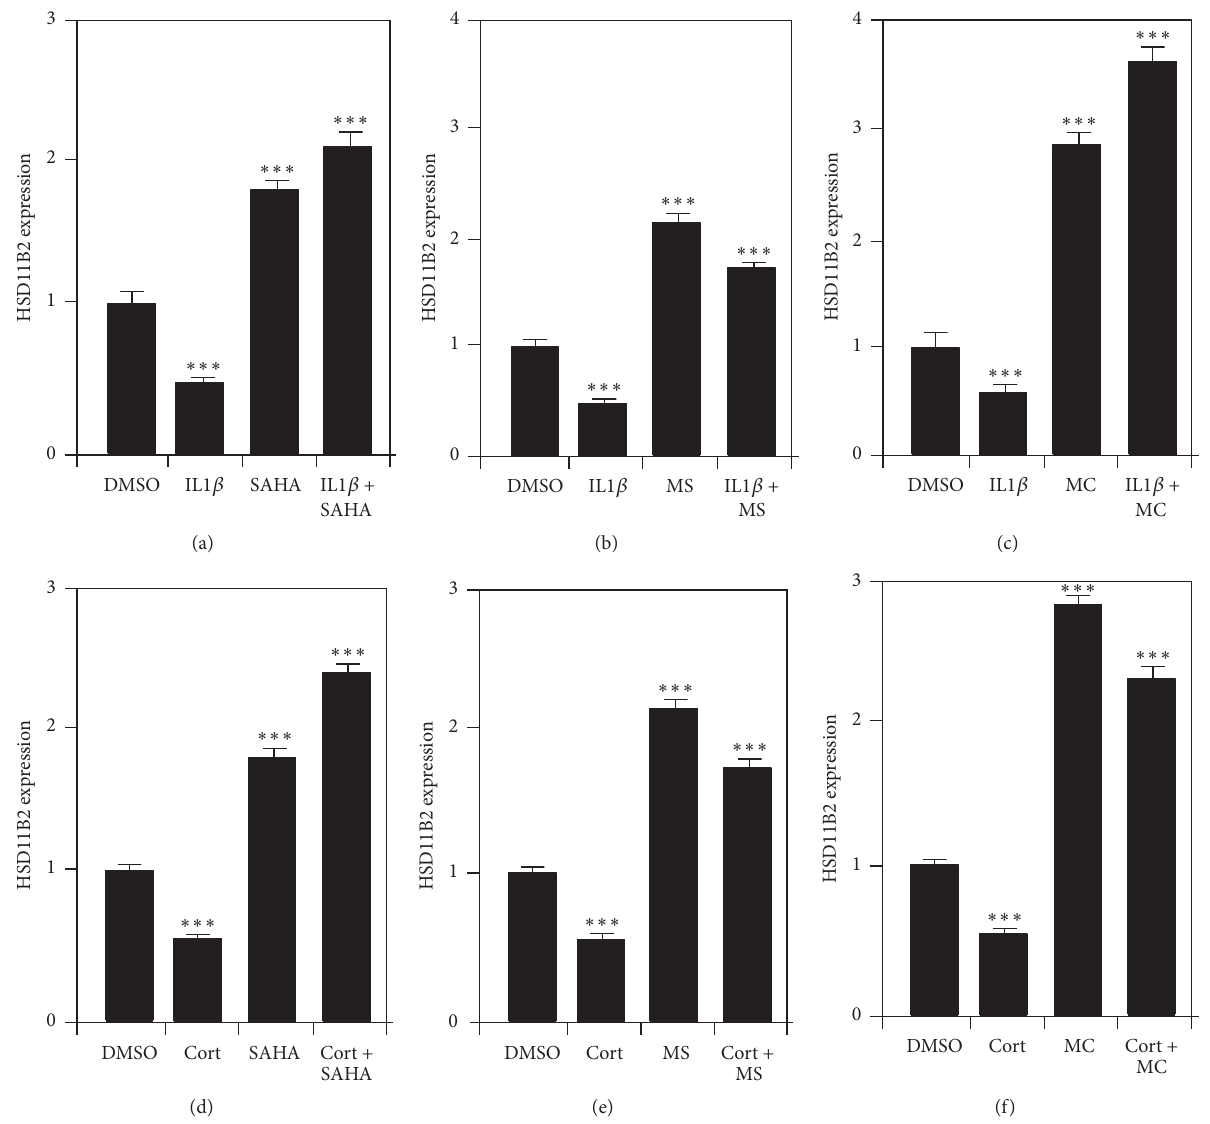
Figure 5: SAHA, MS275, and MC1568 prevent cortisol and IL1 𝛽 -induced decreases in 11 𝛽 -HSD2 expression. Graphical representation and 11 𝛽 -HSD2 expression in JEG-3 cells treated with 2 𝜇 M Cort or 10ng/ml IL-1 𝛽 in the presence or absence of 10 𝜇 M SAHA (a, d), MS275 (b, e), or MC1568 (c, f) for 24 h. Data are expressed as mean ± SEM. ( ∗∗∗ 𝑝 < 0.001 compared to DMSO; one-way ANOVA with post hoc Tukey’s test; 25 cells per group per experiment; 𝑁 = 3